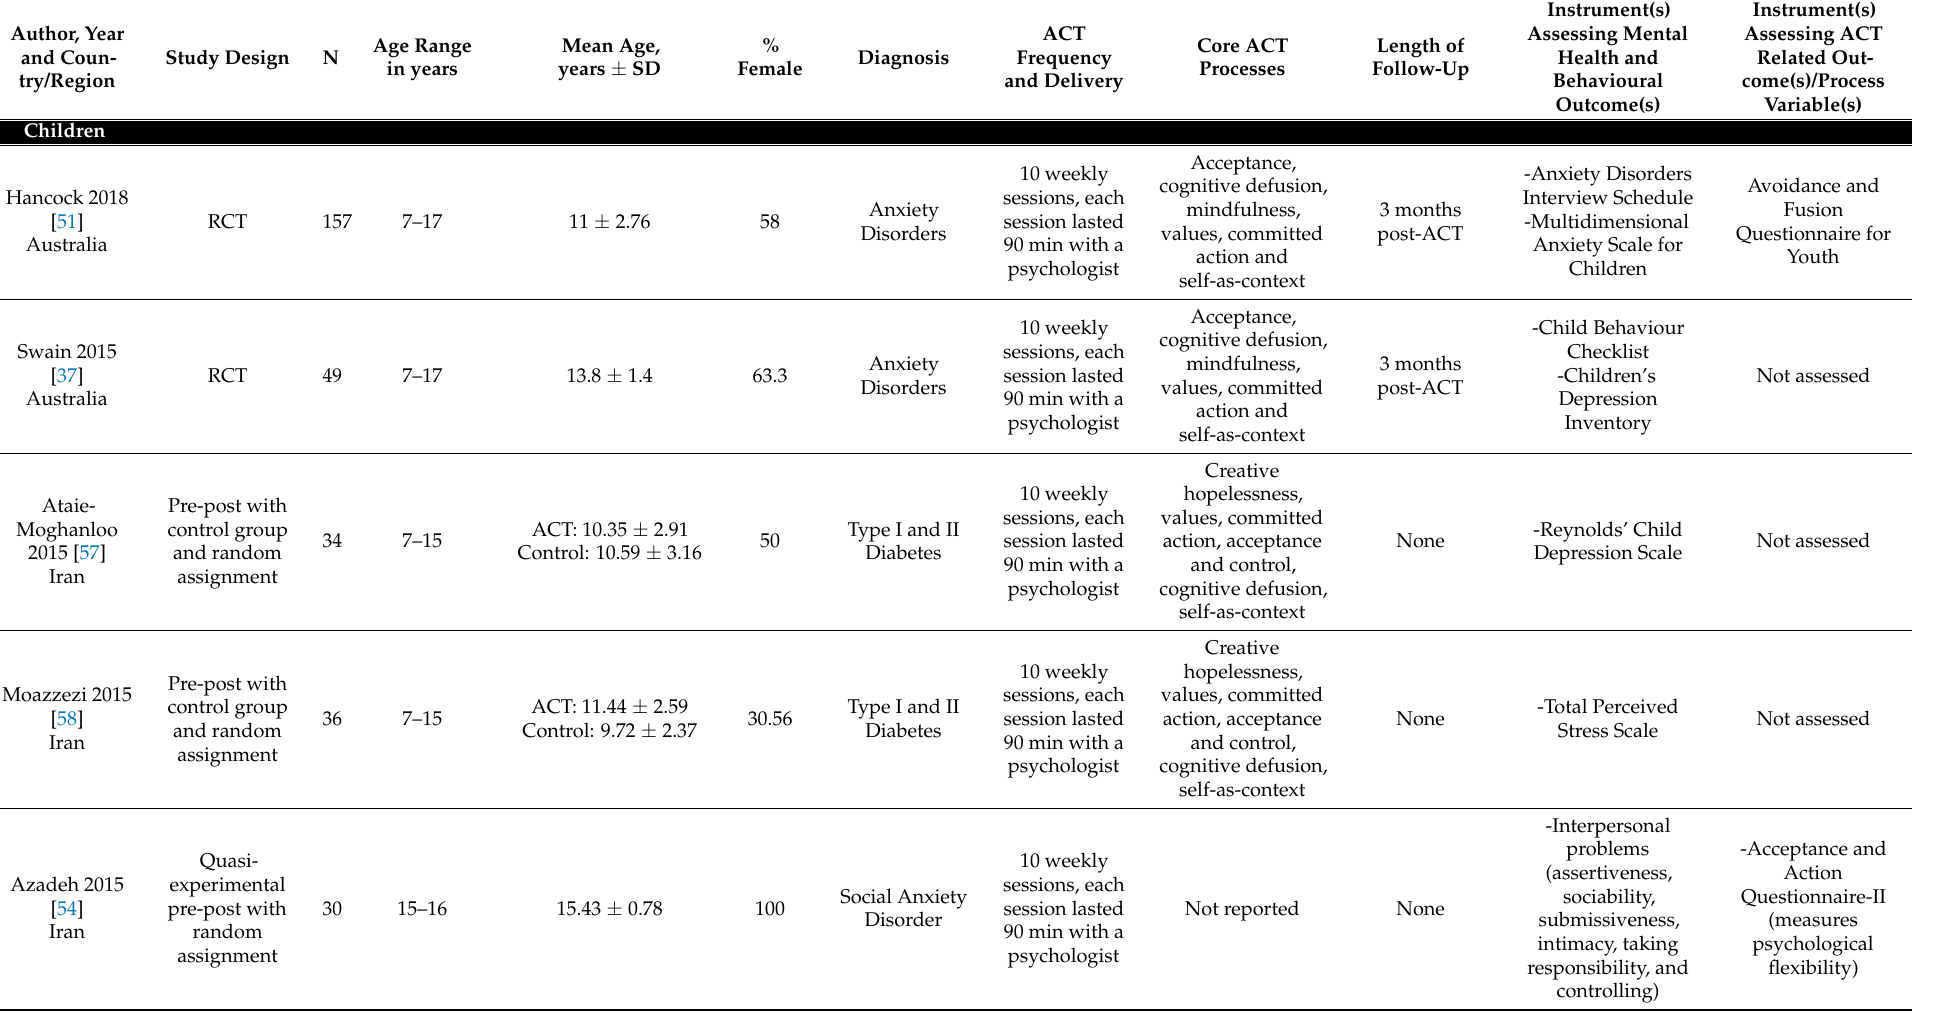
Table 1. Study Characteristics for ACT in Children with SHCN and Parents of Children with SHCN (n =